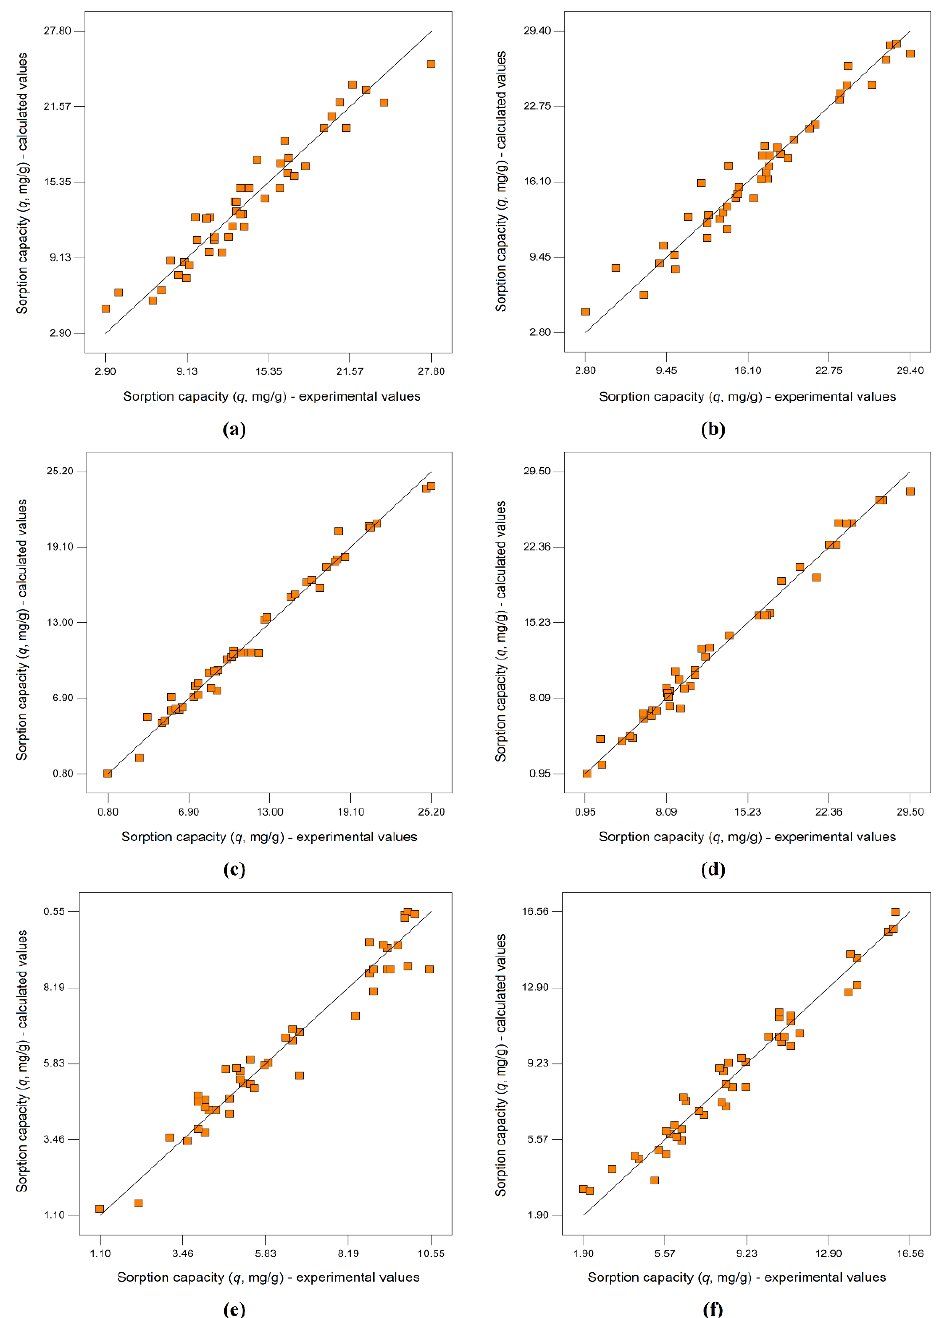
Figure 10. Graphical representation of the concordance between the experimental values and those calculated (predicted) with the mathematical models developed for the biosorption capacity ( q , mg/g) of soybean biomass and soybean waste biomass when adsorbing metal ions ( a ) Pb(II) on soybean biomass; ( b ) Pb(II) on soybean waste biomass; ( c ) Cd(II) on soybean biomass; ( d ) Cd(II) on soybean waste biomass; ( e ) Zn(II) on soybean biomass; ( f ) Zn(II) on soybean waste biomass. To verify the collinearity/multicollinearity of the independent variables (possibly the overestimation of the correlation or determination coefficient as well as the dispersion of the estimated coefficients), the tolerance of the variables x i was tested by the relation (4) and the variance inflation factor, denoted by VIF (relation 5), which shows the extent